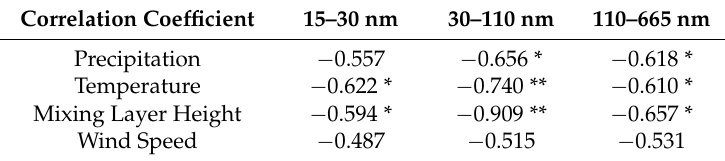
Figure 6. Monthly averaged number concentration of particles in three modes and monthly pattern of wind speed. Table 1. Pearson correlation coefficients between particle concentrations in three modes and meteorological parameters.